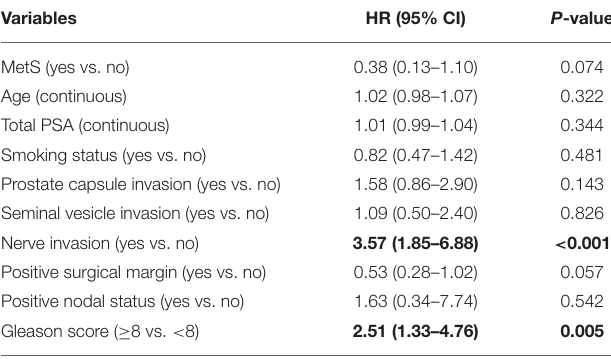
TABLE 5 | Multivariate Cox model analysis of